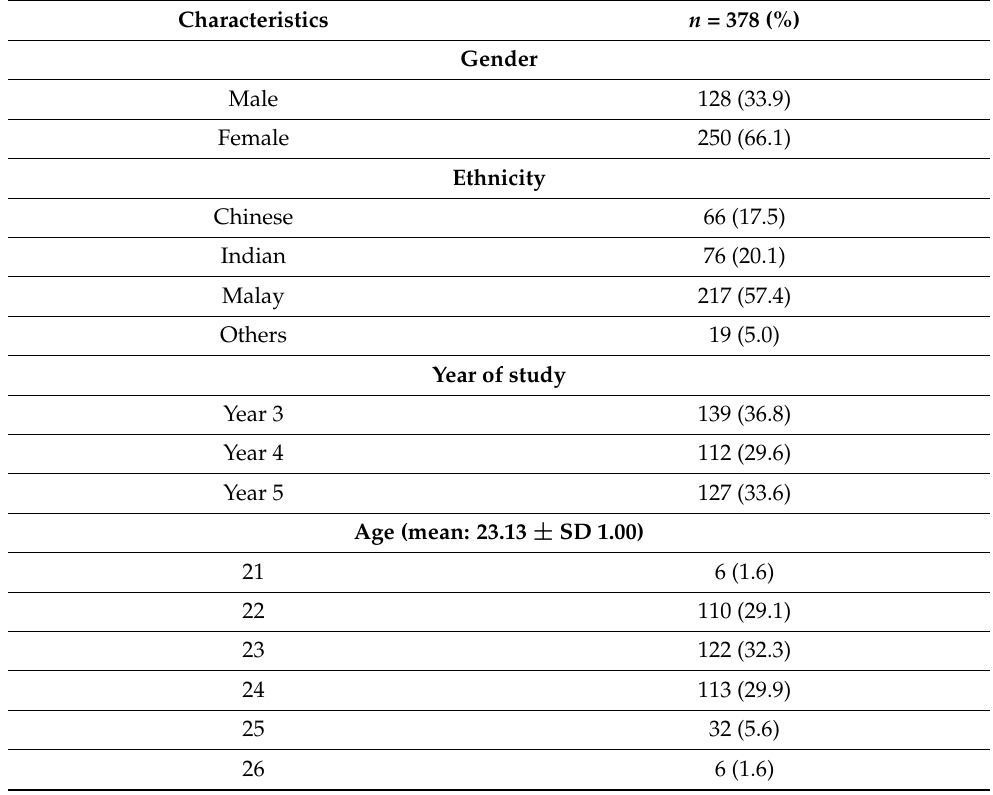
Table 1. Sociodemographic characteristics of the